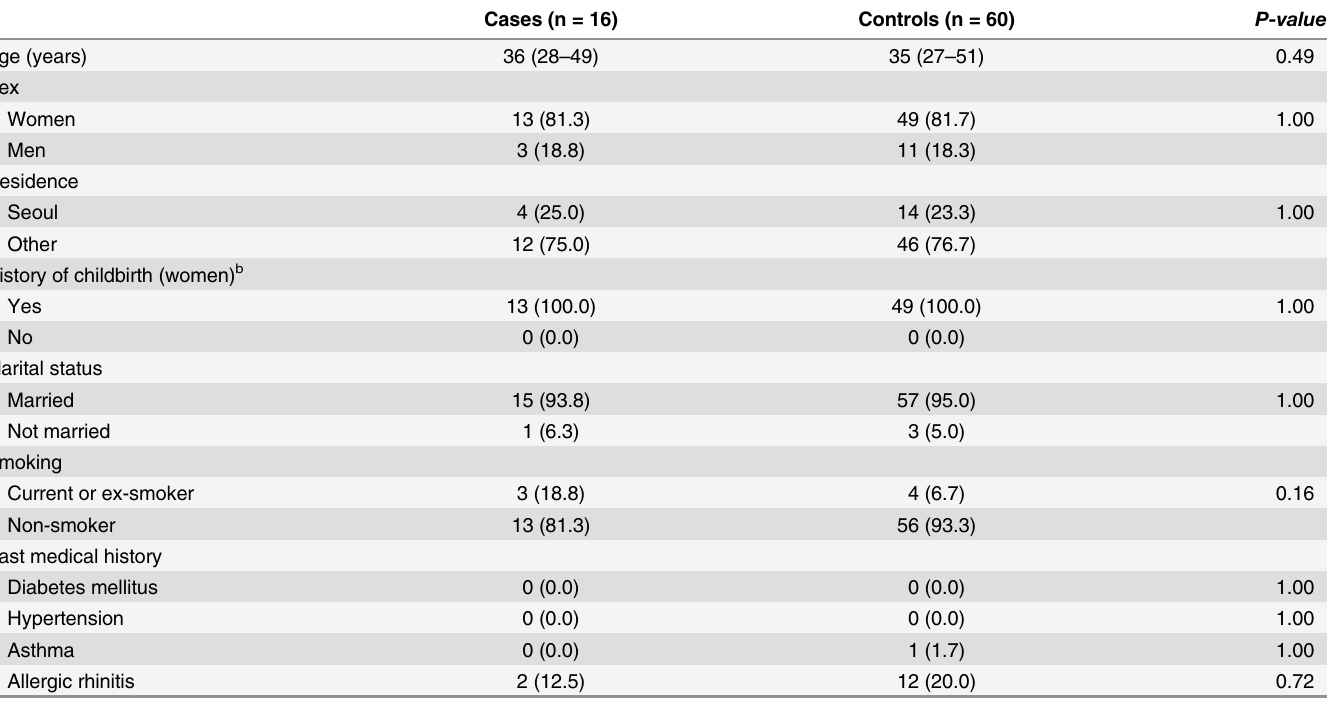
Table 1. Socio-demographic and clinical characteristics of the study